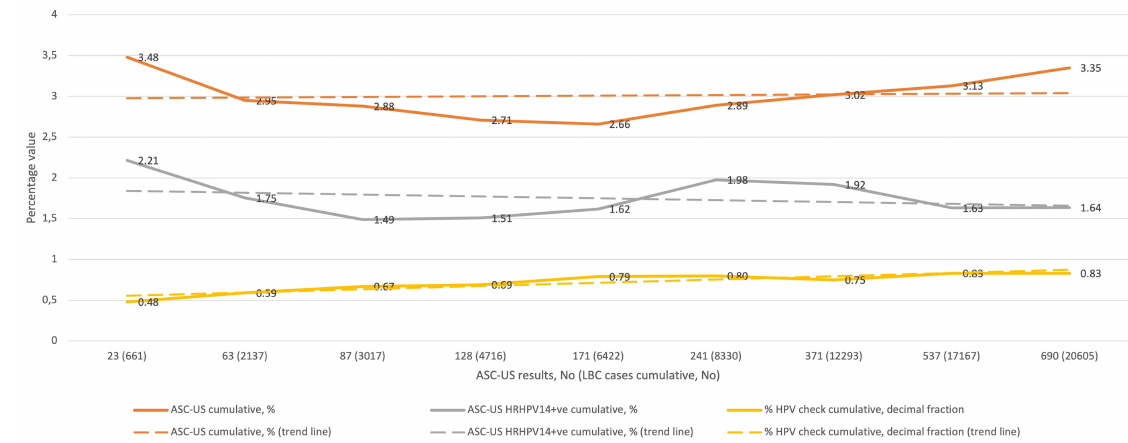
Figure 1. QC results for ASC-US in the study period (1–9 rounds). Abbreviations: QC, quality control; ASC-US, atypi- cal squamous cells of undetermined significance; LBC, liquid-based cytology; HRHPV14, 14 high-risk types of human papillomavirus test; +ve, positive; HPV,